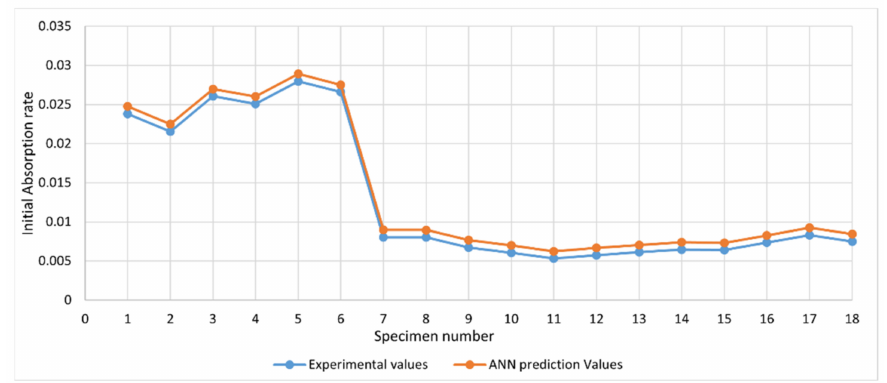
Figure 19. ANN vs. experimental—initial absorption rate of test